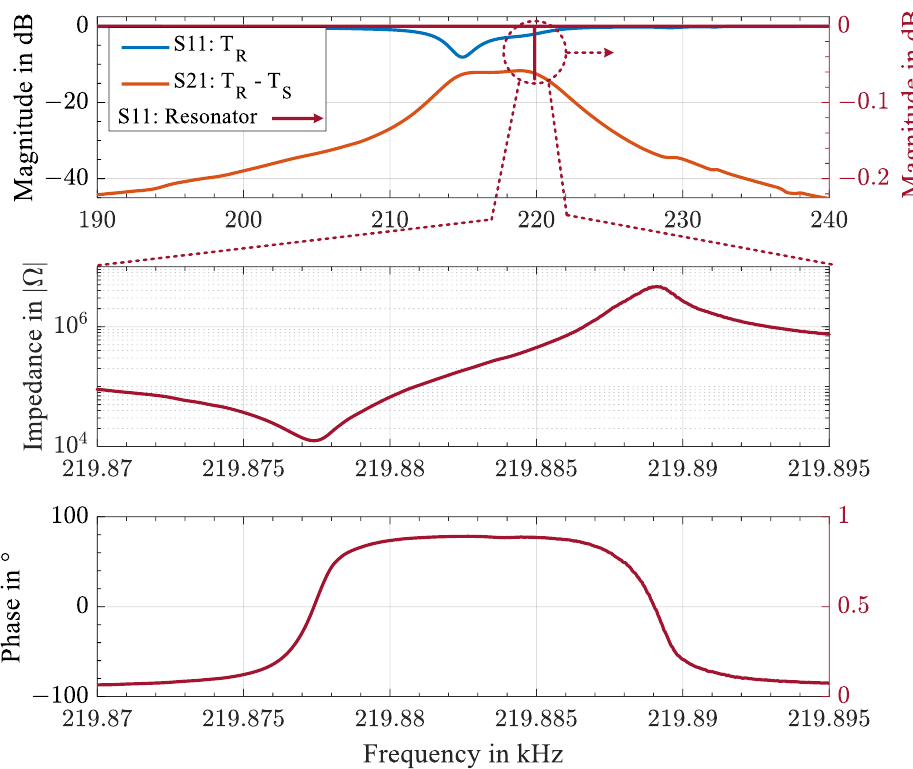
graphs depict the impedance in terms of amplitude and phase in a zoomed-in frequency range of 25 Hz at room temperature.